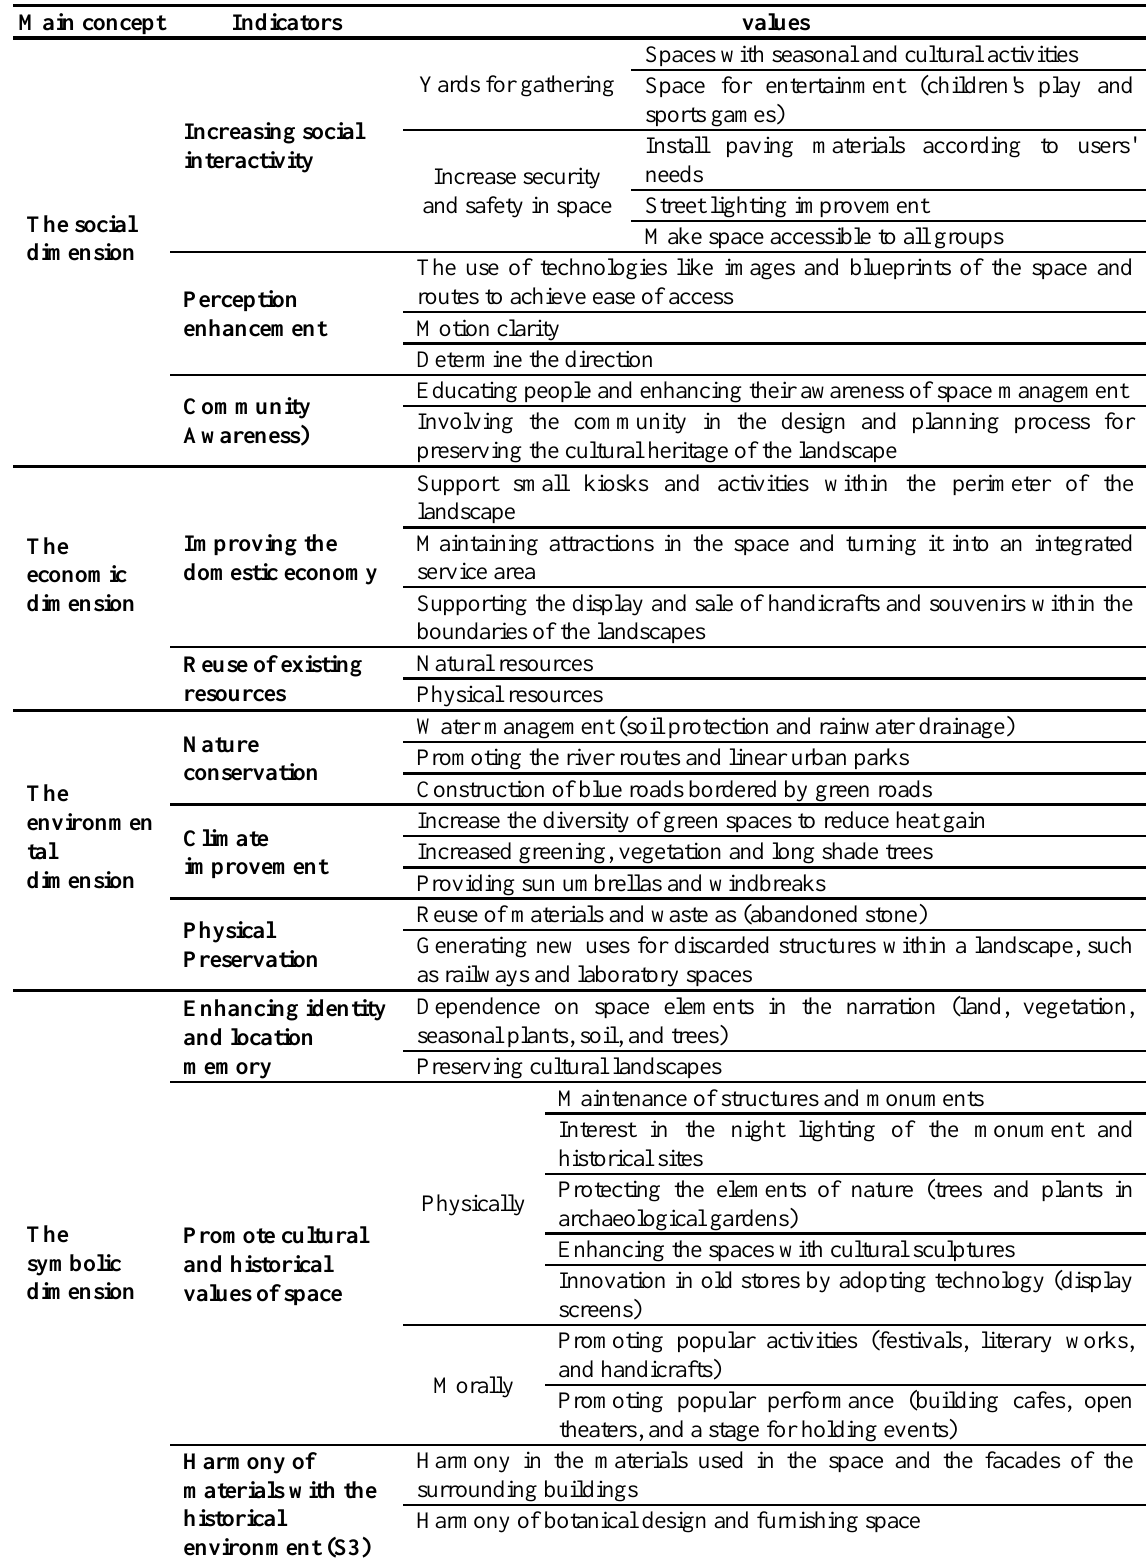
Table 1. The theoretical framework for the dimensions of activating the landscapes, (prepared by the